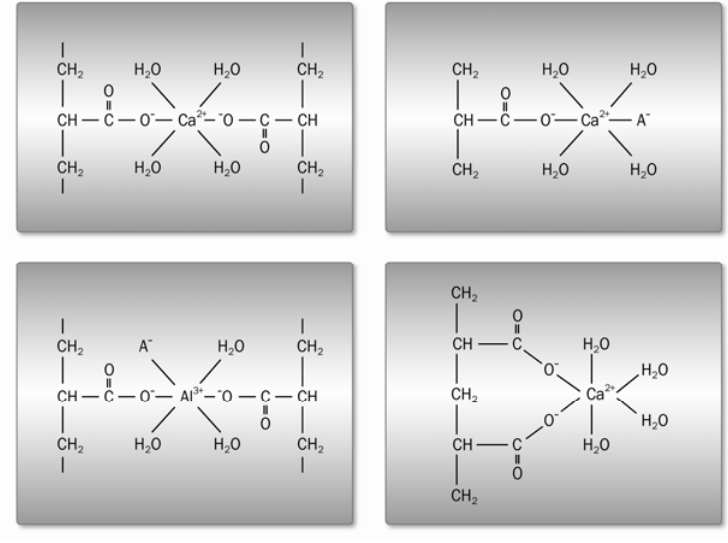
Figure 2. Principal hydrolysis configurations during cement maturation [7].